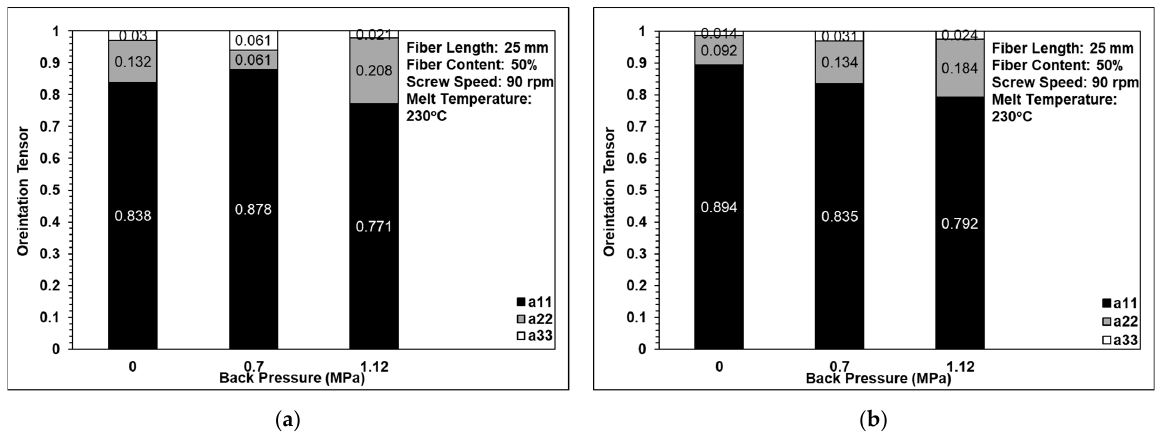
Figure 11. Effects of back pressure on fiber orientation in ( a ) the single-edge gate and ( b ) the single- sprue gate.